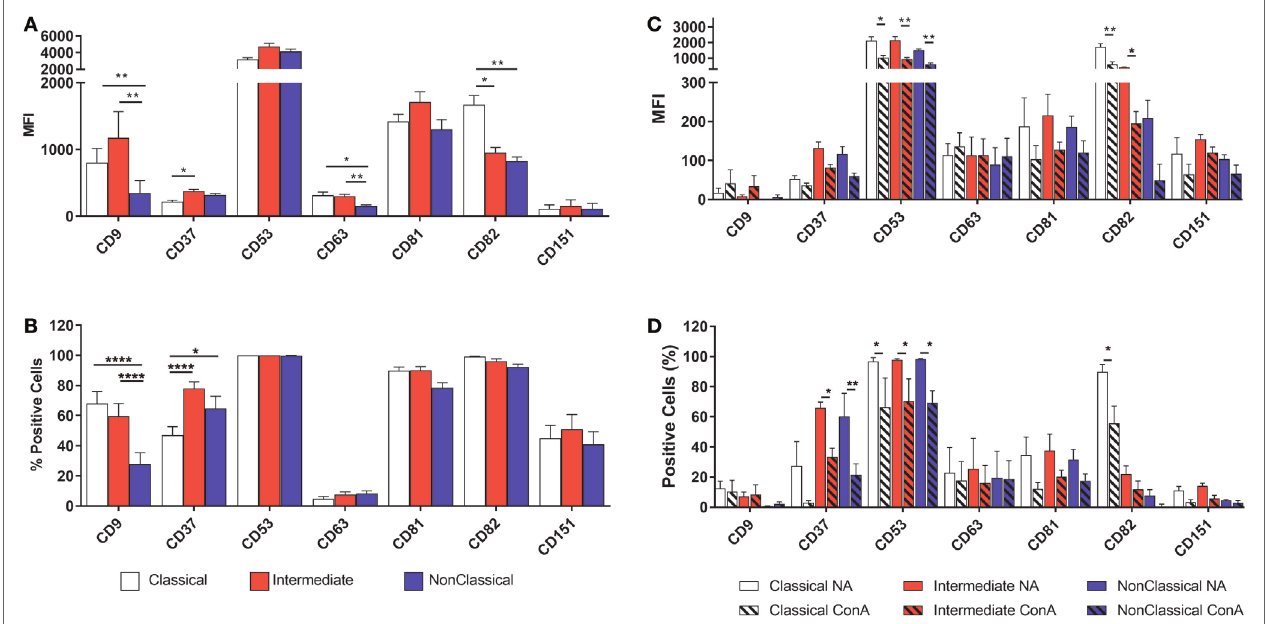
FigUre 4 | Tetraspanin expression varies between monocyte subsets. Monocytes were either freshly sorted into subsets by FACS, or were purified then allowed to adhere, incubated for 4 h with concanavalin A (ConA) to induce fusion and then harvested, before being tested for the expression of a panel of common myeloid cell tetraspanins using flow cytometry. (a) Freshly purified monocyte subsets, expression level per cell (MFI). (B) Freshly purified monocyte subsets, percentage of the cell population with expression above isotype control binding levels. (c) Adherent, ConA treated monocytes, expression level per cell (MFI). (D) Adherent, ConA treated monocytes, percentage of the cell population with expression above isotype control binding levels. The data are the means ± SEM of monocytes from four donors. For (a,B) , significance was tested by two­way ANOVA and a Tukey multiple comparison test. For (c,D) , significance was tested with multiple t tests